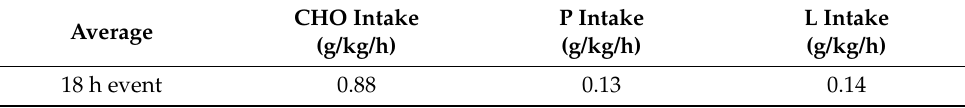
Table 8. Overall macronutrients related to body weight and time